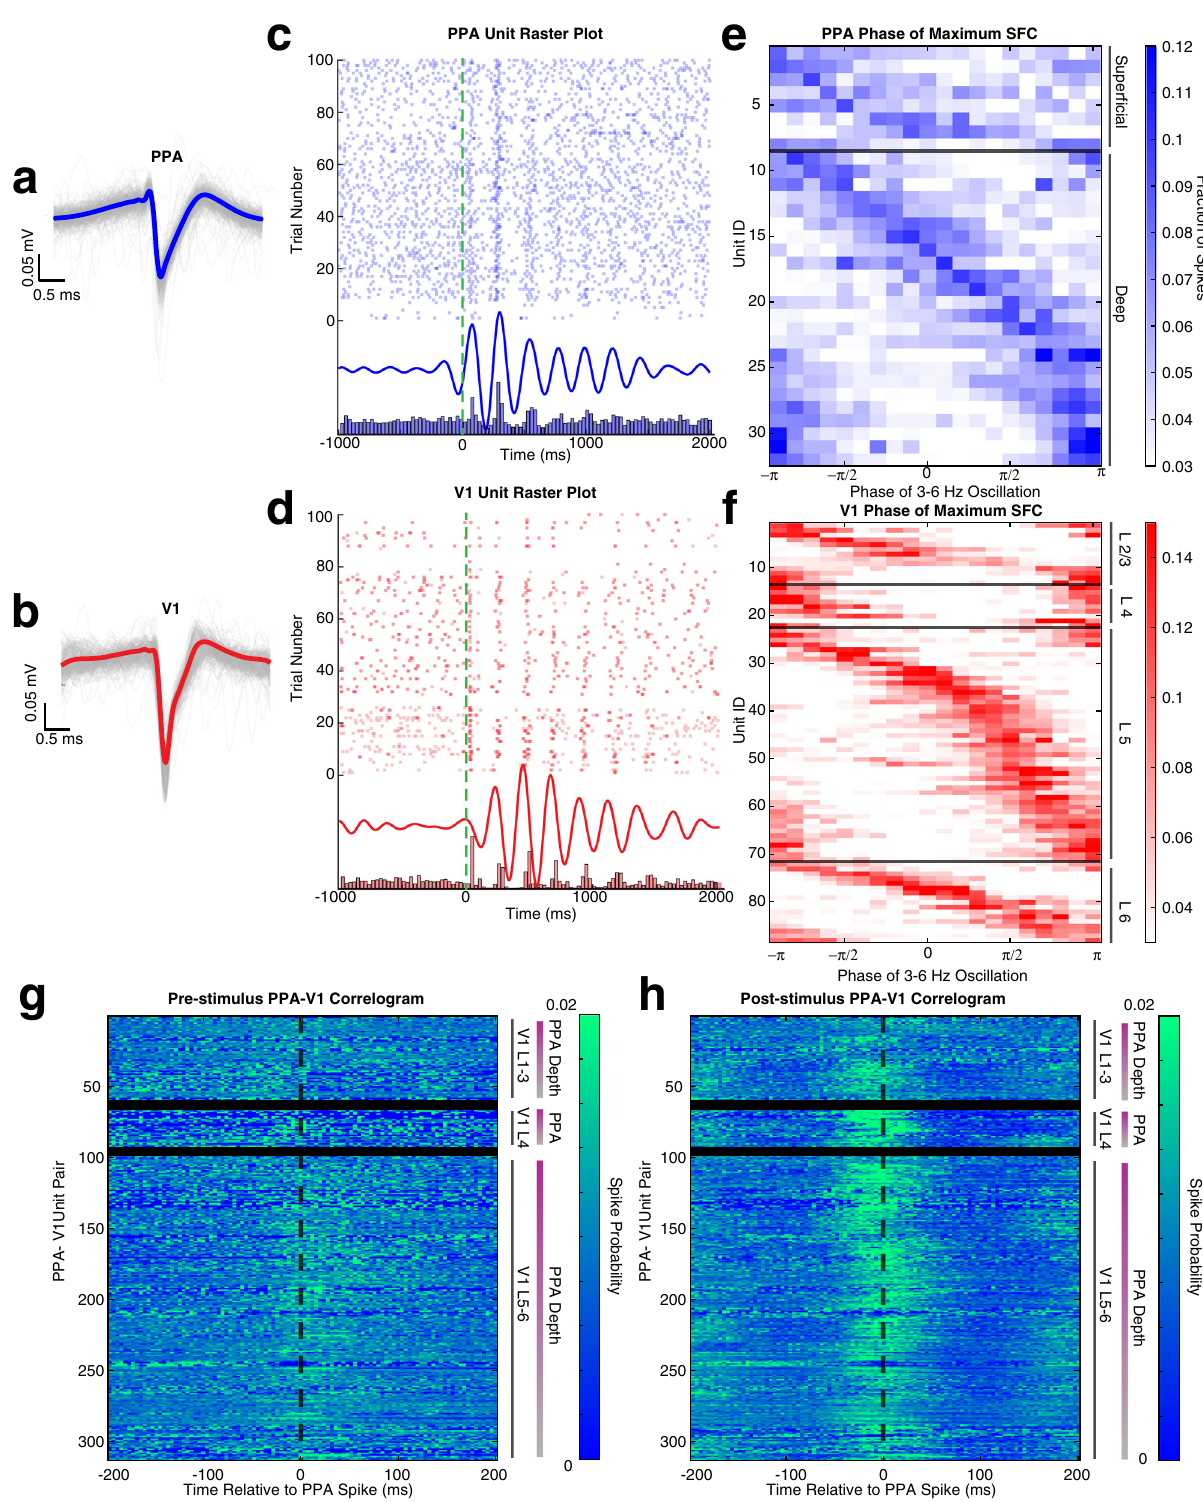
oscillations entrain a signi fi cant fraction of neurons both in the pri- mary visual cortex and the association cortex that involve both feed- forward and feedback interactions. While many single units were entrained in both cortical areas, the phase of maximum fi ring was not the same across different units (Fig. 7e, f). Indeed, the phase of max- imum fi ring in each area swept through an entire cycle of the slow wave. Thus, each visual stimulus evokes a sequence of neuronal acti- vation in both areas that is orchestrated by the slow